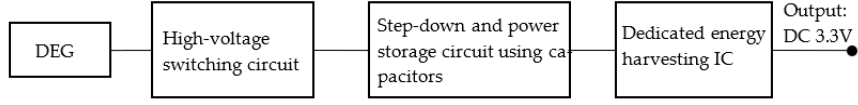
Figure 15. Block diagram of power storage circuit.